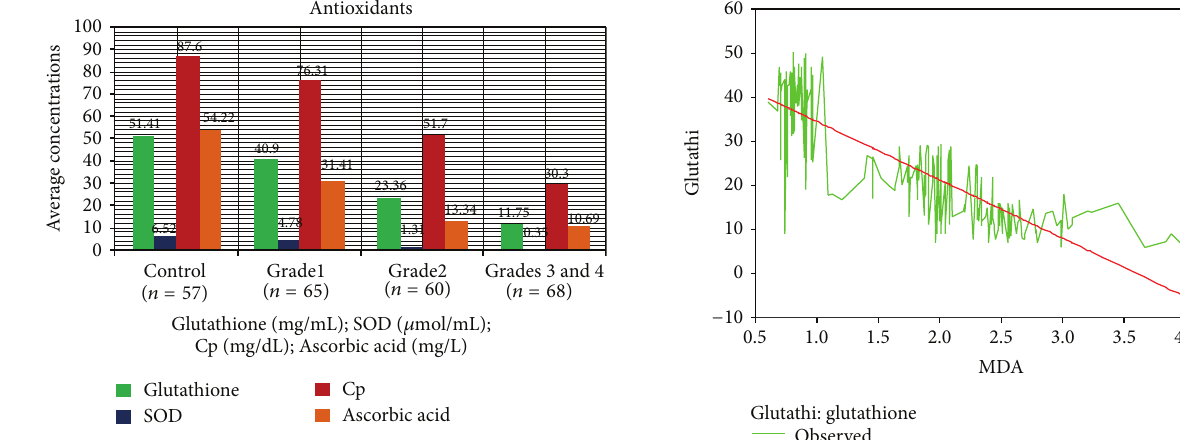
Figure3:Glutathione;CU,ZN-SOD;Cp;ascorbicacidconc.inPEM (cases of different grades i.e, 1, 2, and 3) and control measured by Beutler et al. 1963 [15]; S. Marklund and G. Marklund [13]; Ravin [14]; Roe [12]; method, respectively. Results are expressed as mean ± S.D. 𝑃 < 0.001 while comparing PEM (cases) with control by ANOVA test.